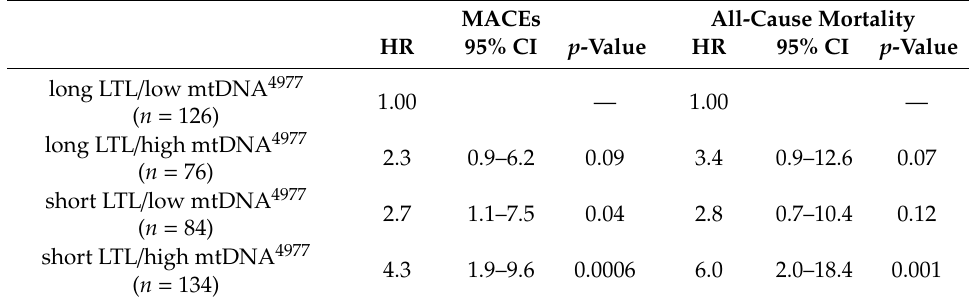
Table 3. Multivariate Cox proportional hazard model for risk of major adverse cardiovascular events (MACEs) and all-cause mortality in groups based on short LTLs and high mtDNA 4977 deletion. MACEs All-Cause Mortality